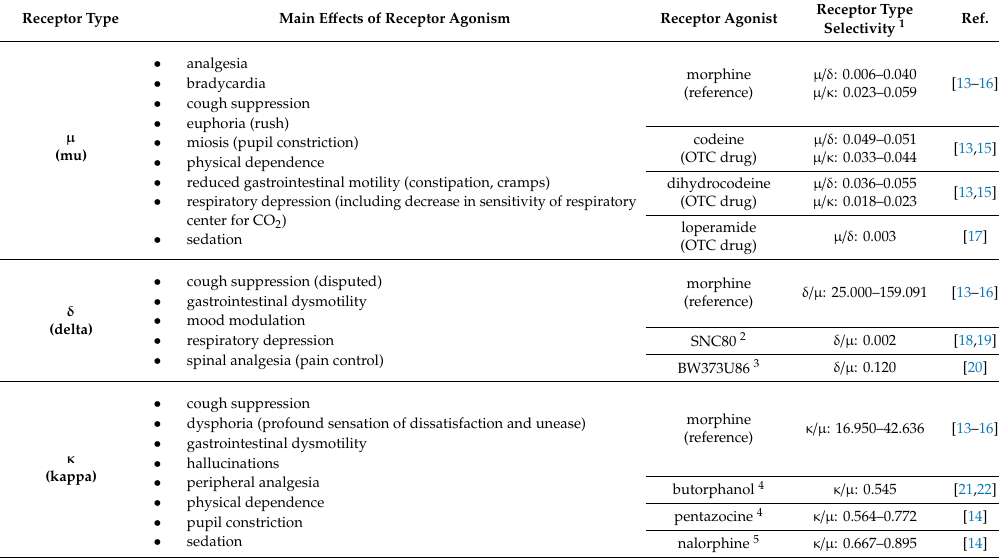
Table 1. Receptor type specific e ff ects of opioid drugs